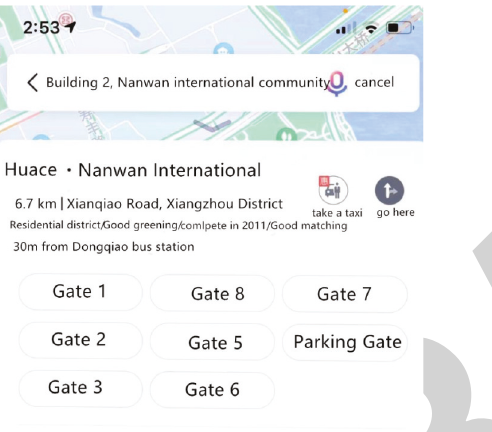
Figure 6: The display interface of searching by Baidu